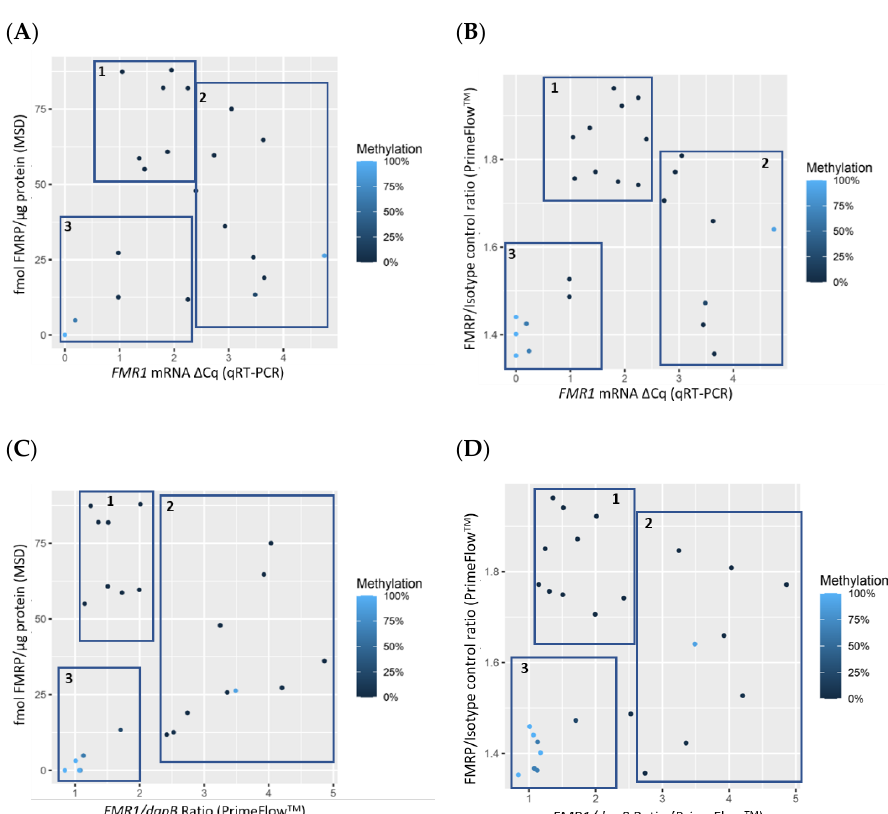
Figure 4. Scatterplots comparing FMR1 and FMRP expression in PBMCs. ( A ) ( n = 22) compares FMR1 mRNA measured by qRT-PCR to FMRP measured by MSD. ( B ) ( n = 25) is a comparison of FMR1 mRNA measured by qRT-PCR to FMRP measured by PrimeFlow TM . ( C ) ( n = 24) compares FMR1 mRNA measured by PrimeFlow TM to FMRP measured by MSD. ( D ) ( n = 27) is a comparison of FMR1 mRNA measured by PrimeFlow TM to FMRP measured by PrimeFlow TM . Regardless of the methods used to measure FMR1 mRNA and FMRP, the data graphs into three groups. Group 1: low FMR1 and high FMRP. Group 2: increasing FMR1 with decreasing FMRP and decreasing FMR1 with decreasing FMRP. Group 3: low FMR1 and low FMRP. Points are colored by % methylation, with lighter blue corresponding to more methylation and darker blue to less methylation. A small amount of random jitter is applied to the x-axis in order to better display overlapping